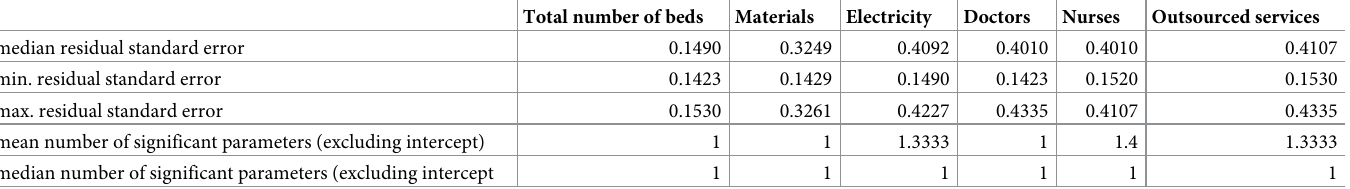
Table 2. Comparison of adjustment of Cobb-Douglas two-input functions according to explanatory variables.